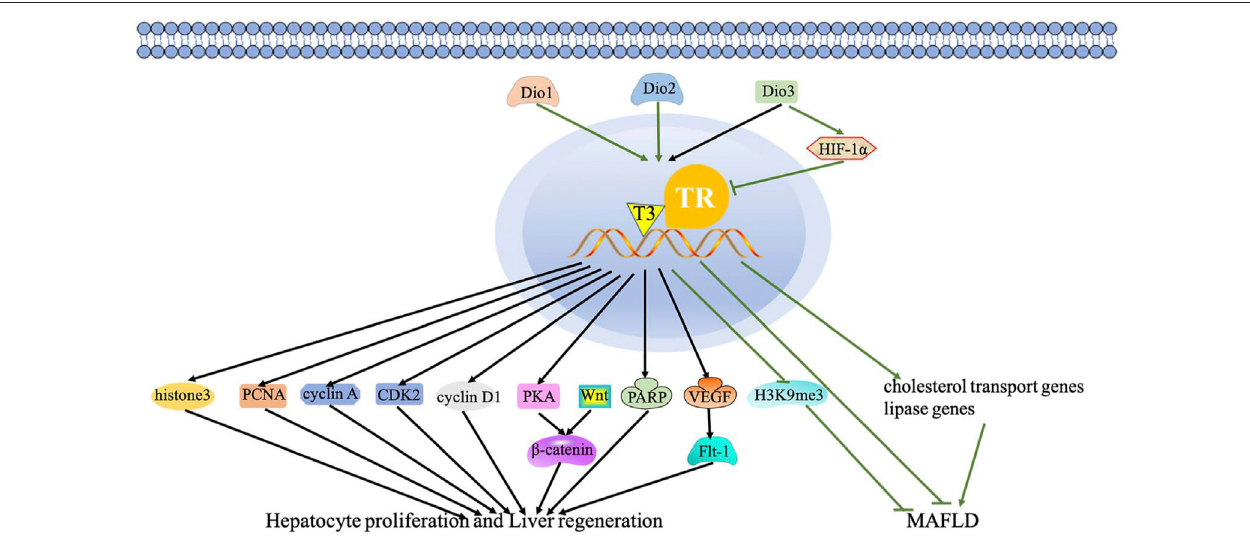
FIGURE 1 | Regulatory mechanism of the TH/TR axis in hepatic proliferation, liver regeneration, and MAFLD. The black lines depict the following: the effect of the TH/TR axis in hepatic proliferation and liver regeneration. TH promotes liver regeneration via elevating histone 3 mRNA, PCNA, cdk2, cyclin A, and cyclin D1. The axis activates β -catenin to induce hepatocyte proliferation through PKA and Wnt-dependent mechanisms. PARP participates in liver regeneration induced by TH. The decrease ofDio3elicitsTH-dependenthepatocyteproliferation andliver regeneration. T3improvesliverregenerationbypromotingtheVEGFand Flt-1expression. The green lines represent the following: the TH/TR axis might improve MAFLD. Dio3 activates HIF-1a, thus inhibiting T3 signaling. Genes related to reverse cholesterol transport and lipase activity decrease with the downregulation of Dio2 in rats. TH is produced by Dio2 and then depletes H3K9me3. (For interpretation of the references to color in this fi gure legend, the reader is referred to the Web version of this